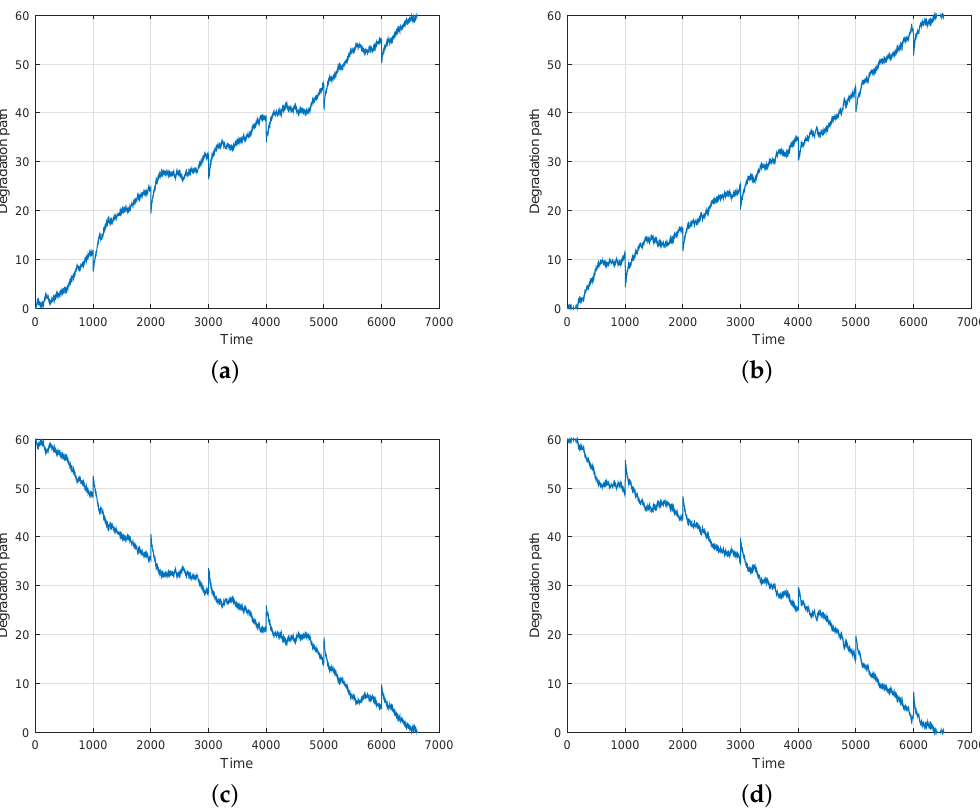
Figure 2. The simulated degradation trajectories generated from the proposed model. ( a ) The degradation trajectorywithfixedregeneration; ( b )Thedegradationtrajectorywithrandomregeneration; ( c ) The degradation trajectory with negative rate and fixed regeneration; ( d ) The degradation trajectory with negative rate and random